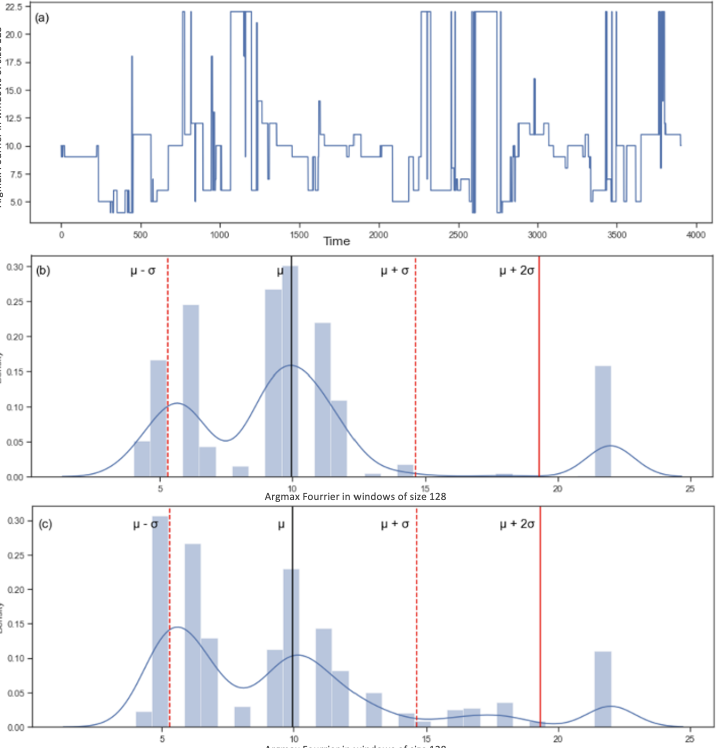
Figure 12. The upper panel ( a ) represents the argmax of the absolute value of the Fourier transform for each window of 128 values. The middle panel ( b ) represents the training distribution of the values in ( a ). The values that are between the two red lines µ − σ and µ + σ (around 5 and 15) represent normal breathing rates. The values that are on the left of µ − σ (0 to around 5) represent slow breathing rate and the values that are located at µ + σ and more represent fast breathing rate. The lower panel ( c ) represents the testing distribution compared to the threshold defined in panel ( b ).